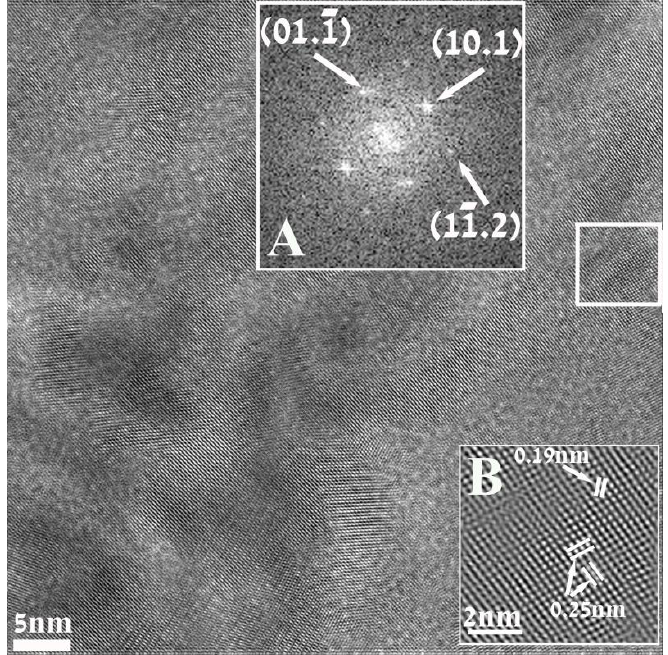
and d family of planes. 10.1 10.2